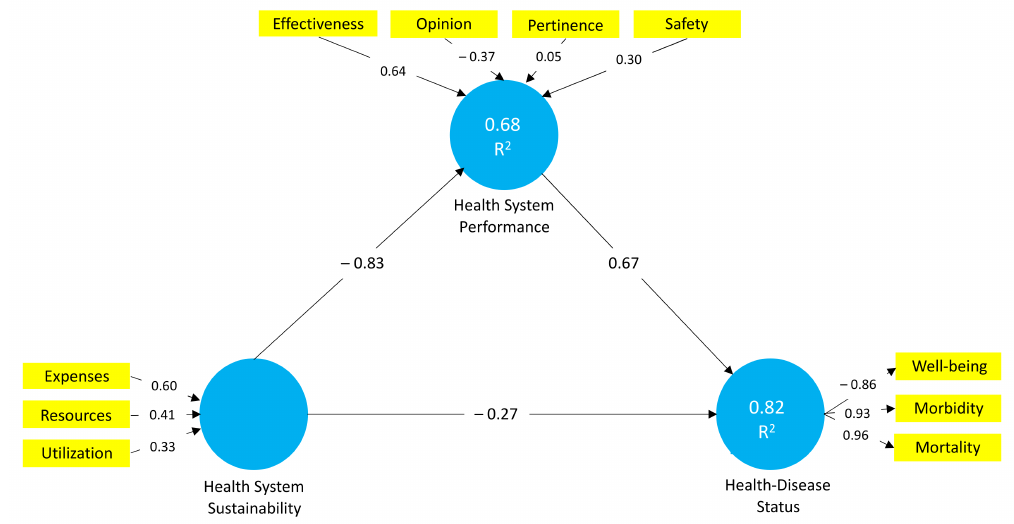
Figure 3. The second step: higher-order composites’ structural model. Health system sustainability, health system performance, and health–disease status are higher-order constructs